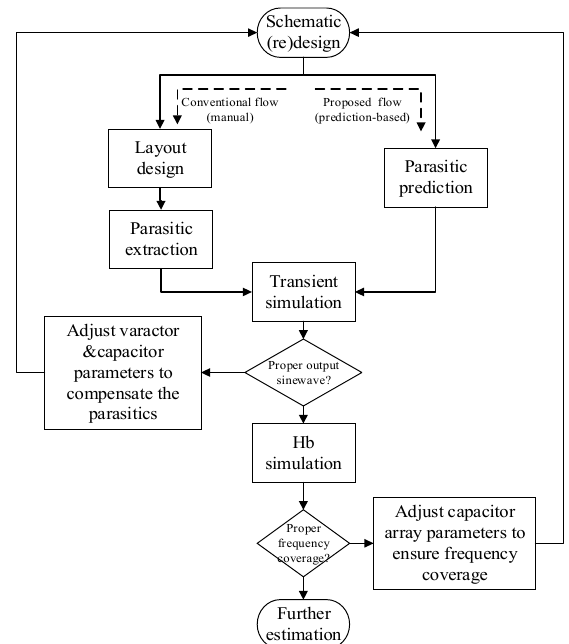
Figure 6. Optimization flow of the VCO.